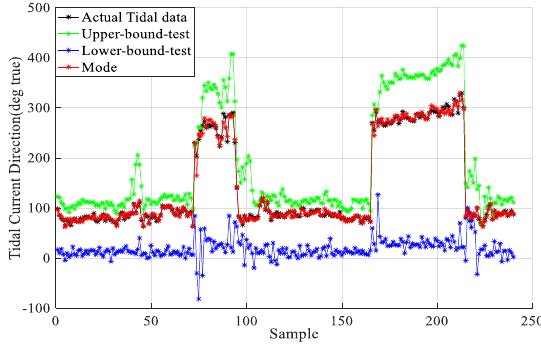
Figure 4. Tidal current speed prediction results.